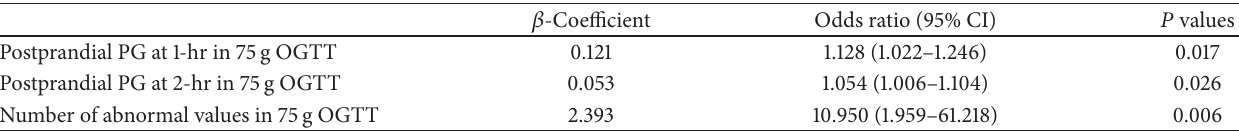
Table 3: Logistic regression analysis with each independent variable of predictors for antenatal insulin treatment (AIT). 𝛽 -Coefficient Odds ratio (95% CI) 𝑃